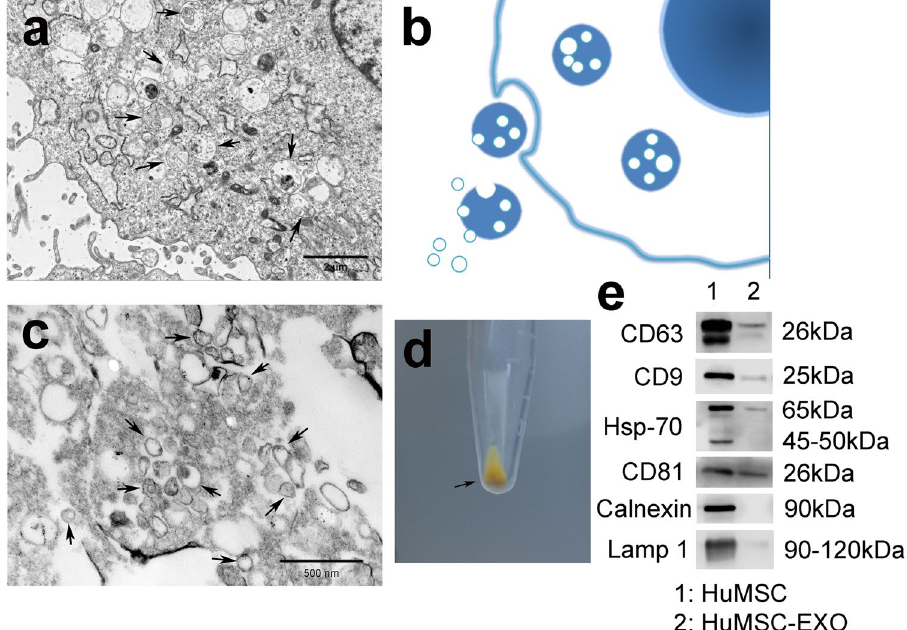
Figure 2. Typical characteristics of huMSC-EXOs. ( a , b ) The cellular lipid bilayer is retracted to form multi- chambered vesicles, which release nanoscale vesicles, named exosomes, in a calcium-dependent manner that bind to cell membranes. ( b ) The simulation diagram. ( c ) TEM showed the morphology of exosomes, which were 30–200 nm in diameter. ( d ) The exosomes precipitated in the bottom of the tube, and were a light yellow colour. ( e ) Western blotting analysis indicated that huMSC-EXOs expressed exosomal markers, such as CD63, CD9, Hsp70 and CD81 proteins. However, calnexin and Lamp1 were not expressed; n = 5.